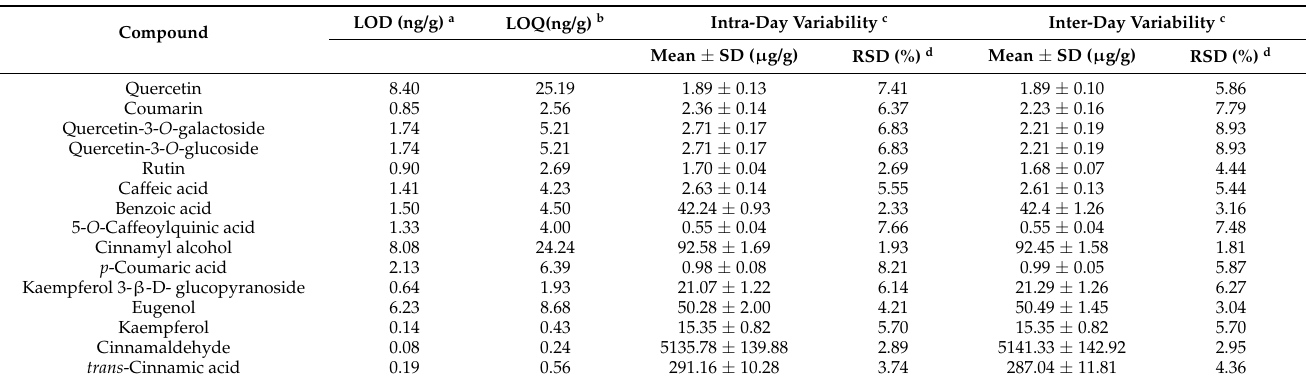
Table 5. Quality control data of cinnamaldehyde and the other bioactive compounds in C. osmophloeum leaves by